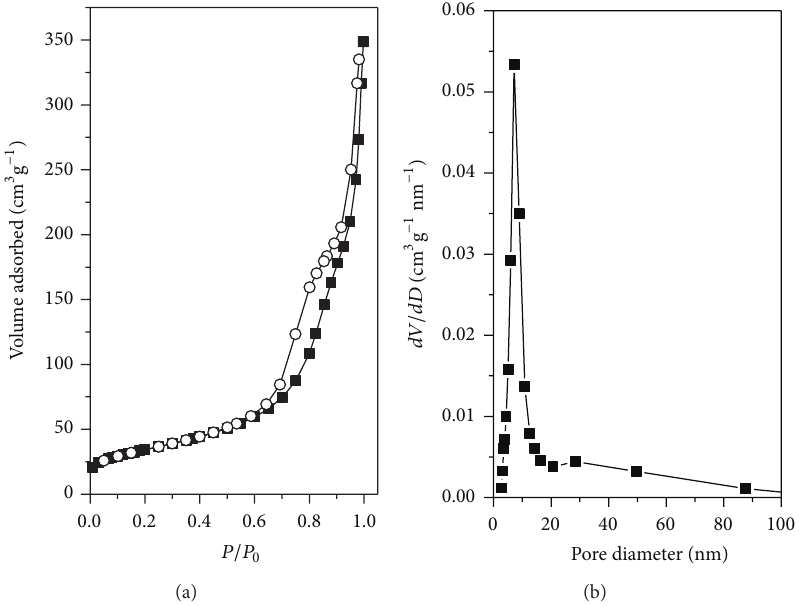
Figure 3: N 2 isotherms (a) and BJH pore size distribution plots (b) of the prepared porous 𝛾 -Fe 2 O 3 .